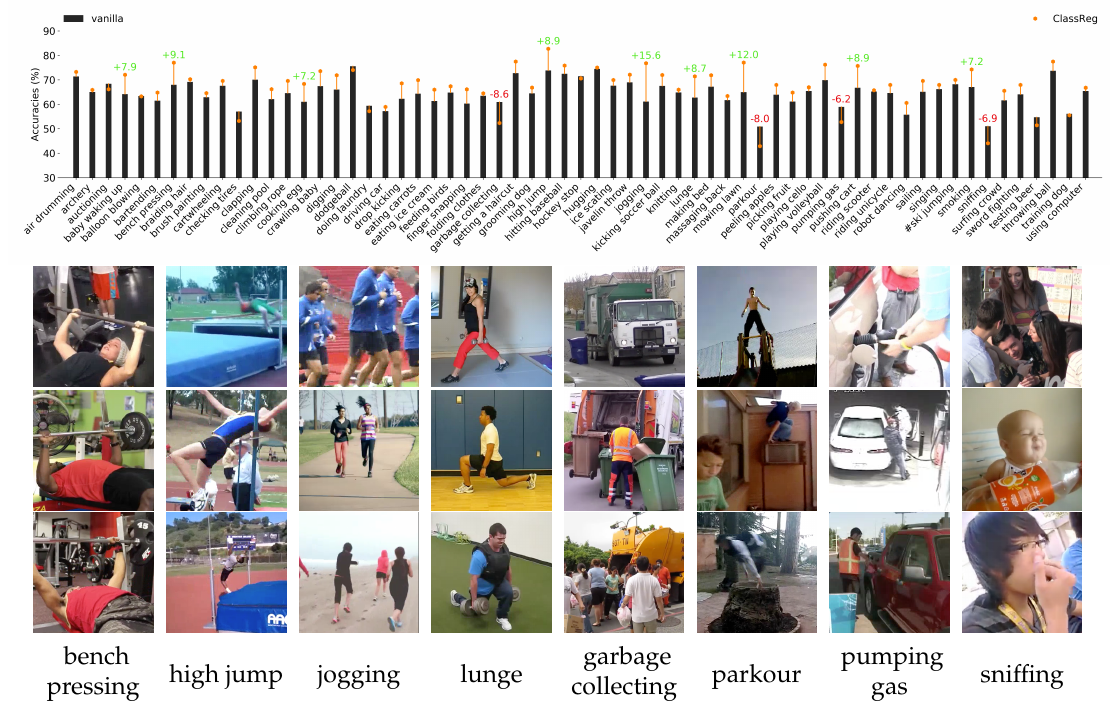
Figure 5. Per-class performance for ResNet-101 w/o Class Regularization with illustrative examples of classes with large performance gains or losses in Kinetics-400